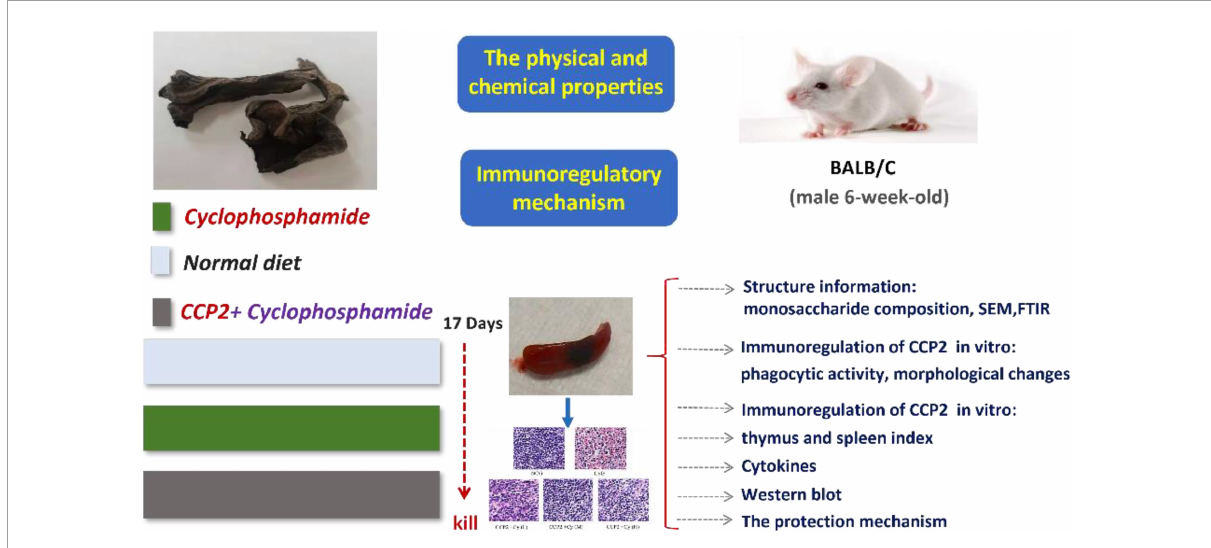
FIGURE7 The sketch map of the immunoregulatory induced by CCP.